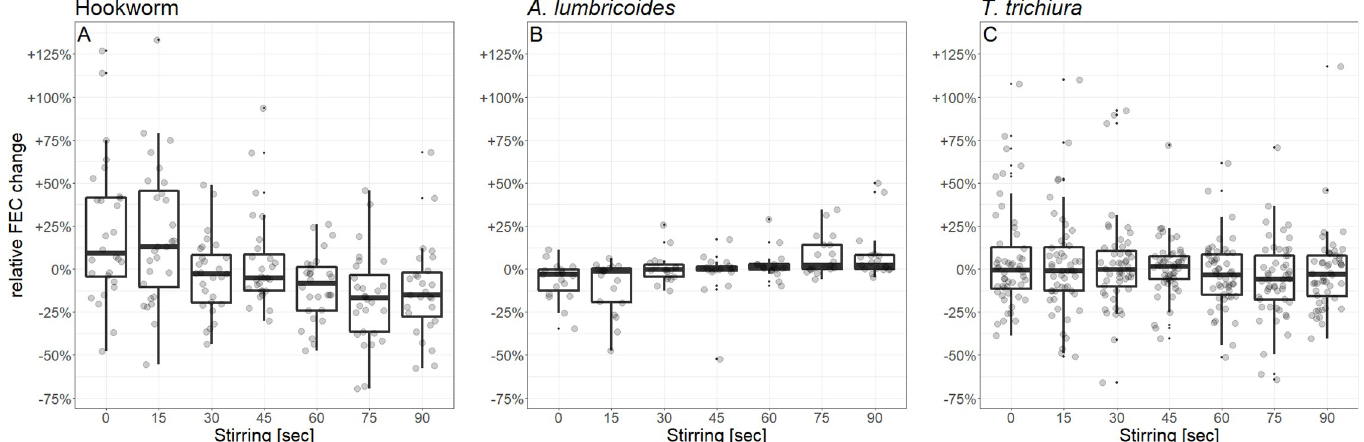
Fig 6. Homogenizing experiment: Relative fecal egg counts (FEC) differences from the overall mean per sample (over 7 observations) after different lengths of homogenization for (A) hookworm (n = 28), (B) A . lumbricoides (n = 19) and (C) T . trichiura (n = 52). Figures show boxplots and observed values (jittered). A . lumbricoides = Ascaris lumbricoides , T . trichiura = Trichuris trichiura .